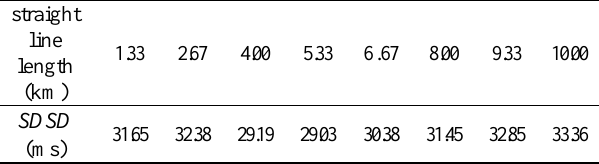
Tab.5. Data of straight line length and SDSD